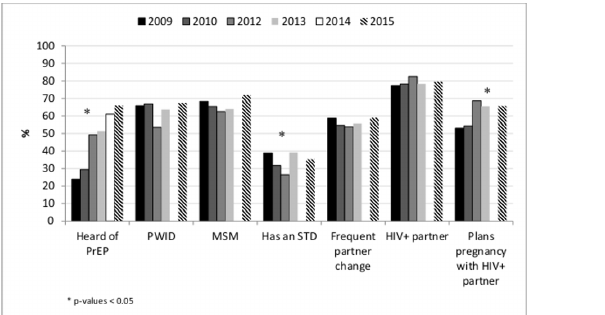
Fig 1. Awareness of PrEP and Willingness to Prescribe PrEP to Persons with Selected Risks for HIV Acquisition by Survey Year, DocStyles, 2009 – 2015, United States.